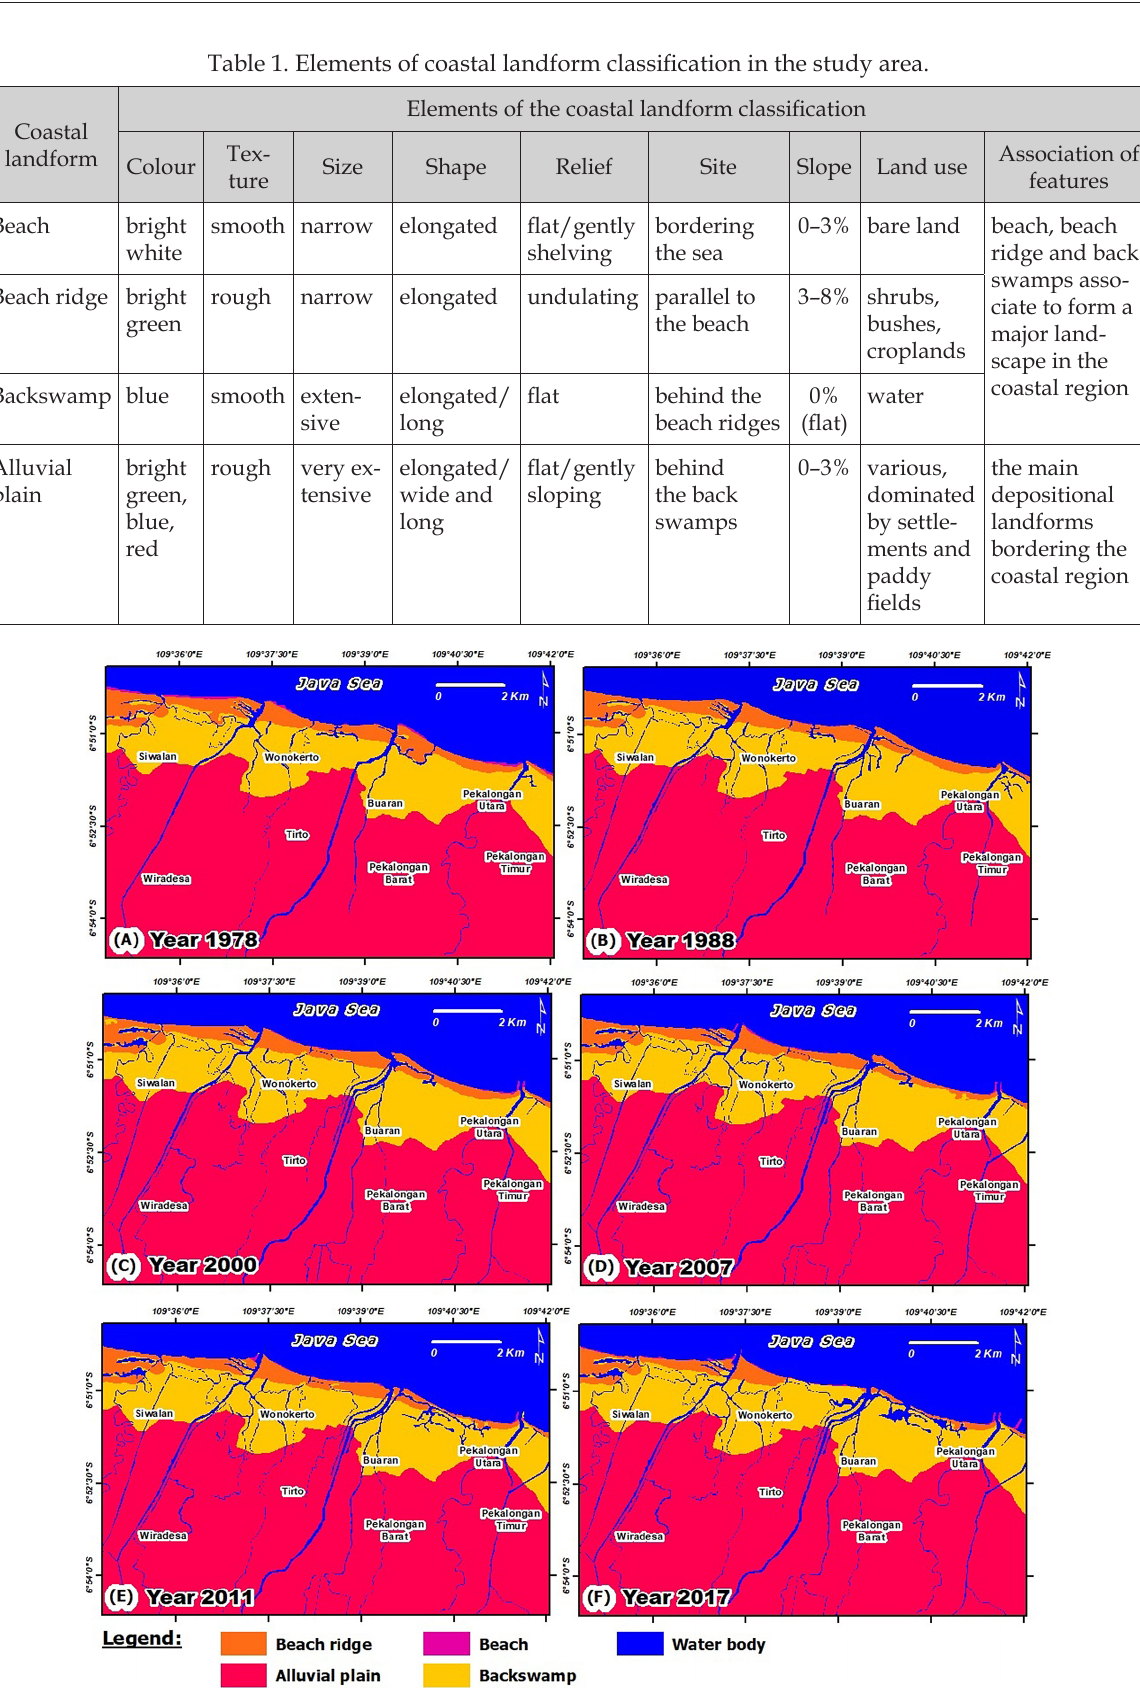
Fig. 5. The results of coastal landform mapping and change from 1978 to 2017 in the study